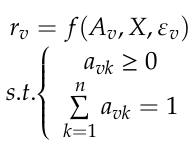
Figure 1. Network architecture of the proposed attention-based residual network with scattering transform features (ARNST).